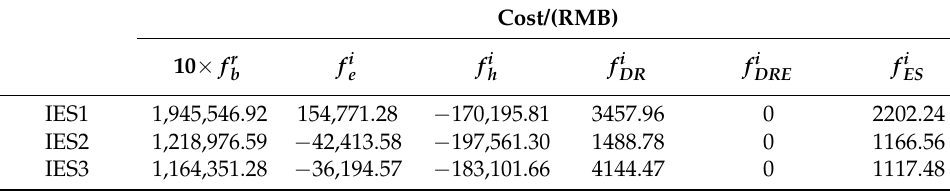
Table 13. Case 3 results.